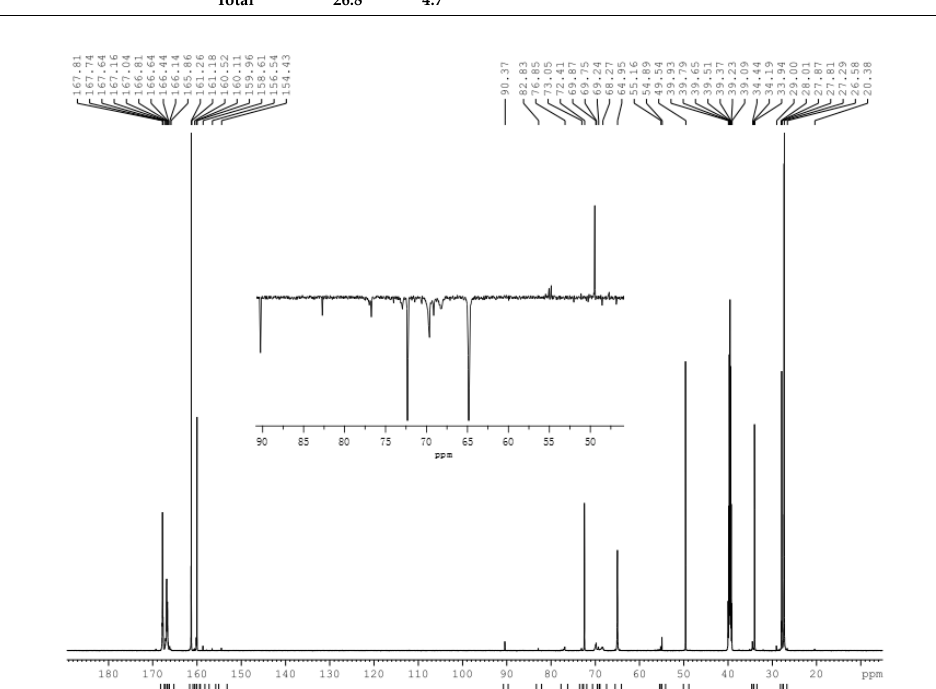
Figure 7. The 13 C-NMR spectrum of sample C1.